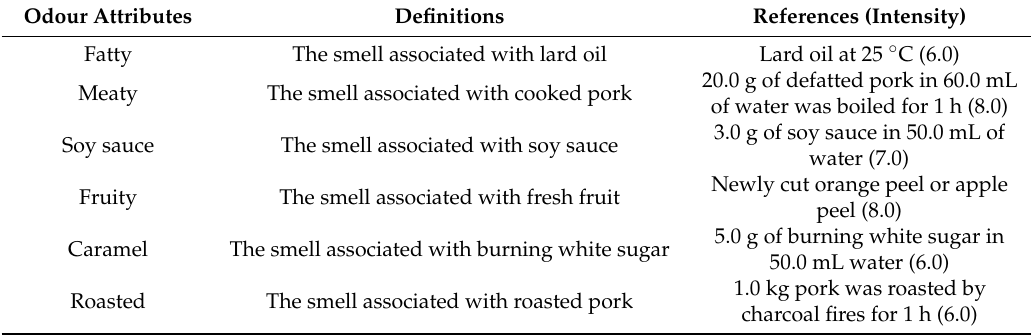
Table 4. Definitions of odour attributes and reference